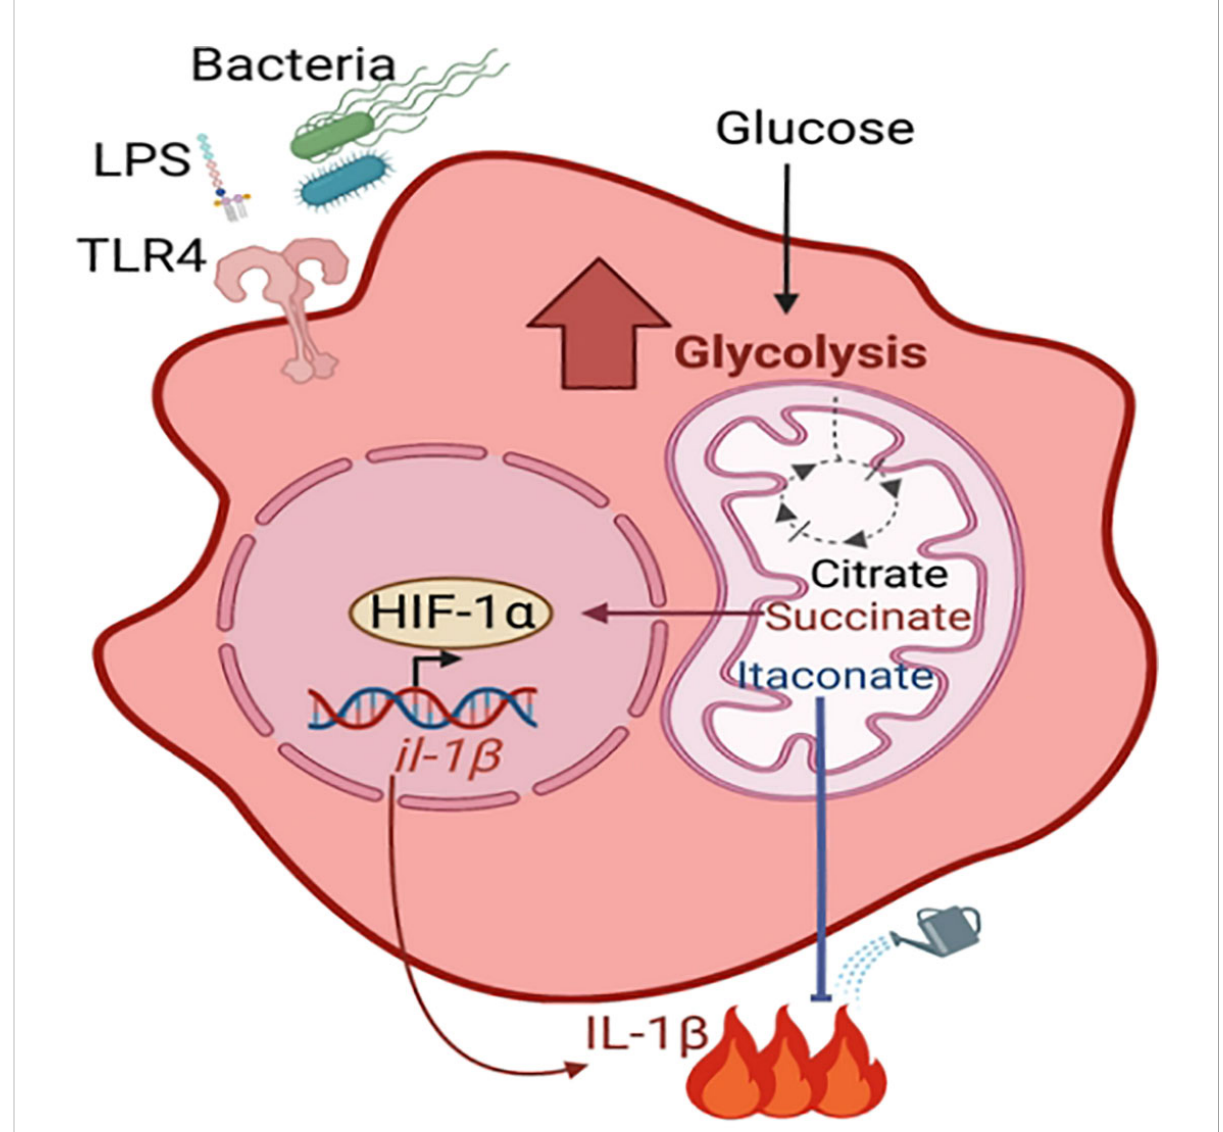
FIGURE 1 Metabolic reprogramming of macrophage. During infection with live bacteria or upon stimulation with PAMPs such as LPS, macrophages become activated for pathogen clearance (pro-in fl ammatory M1 phenotype) by undergoing metabolic changes. These include increased glycolysis and accumulation of TCA cycle metabolites such as citrate, succinate and itaconate. Succinate stabilizes the transcription factor HIF-1 a , which promotes the production of proin fl ammatory cytokines. Itaconate dampens the succinate-induced in fl ammation via its anti- in fl ammatory